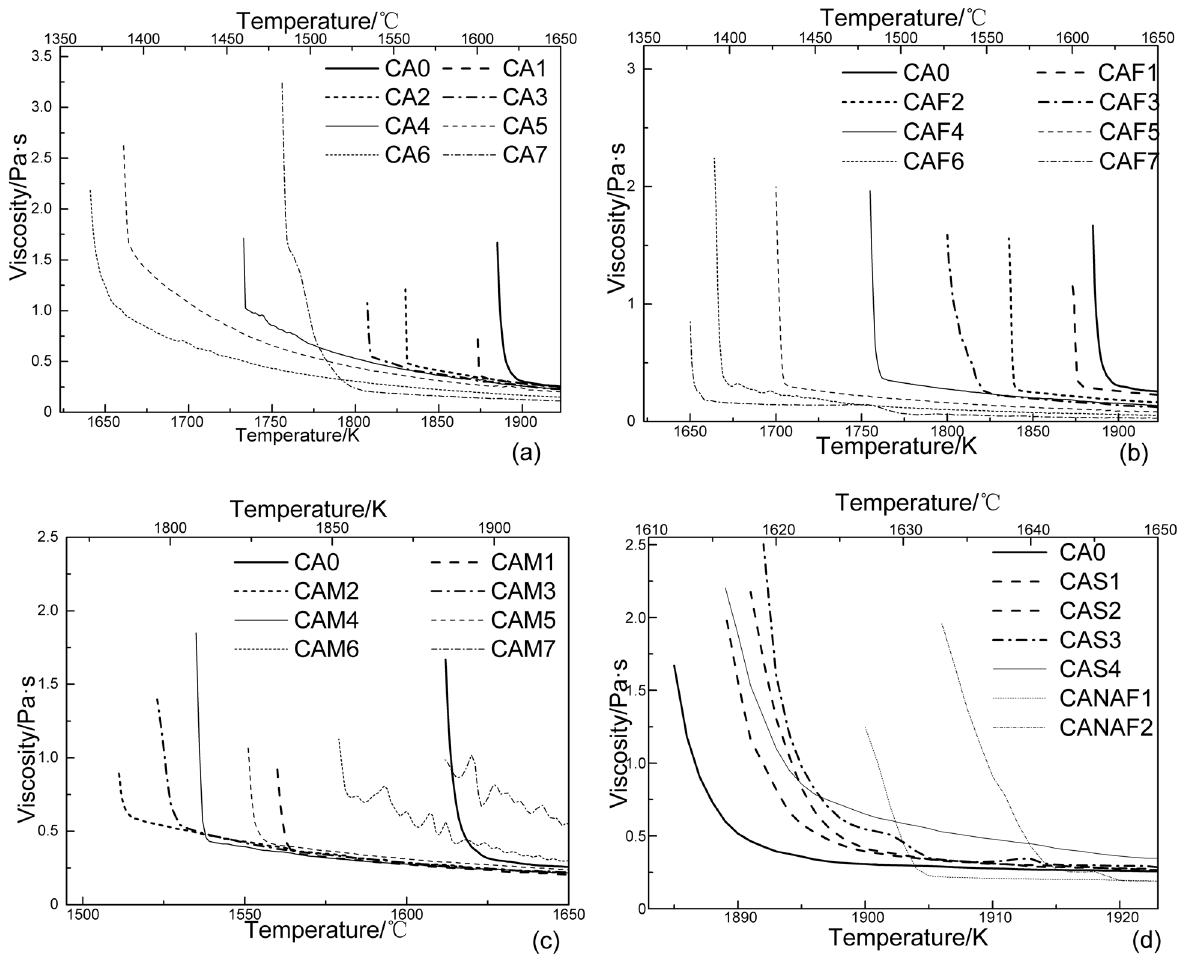
Figure 2: E ff ect of di ff erent additives on viscosity – temperature curves of slags: ( a ) CaO; ( b ) CaF 2 ; ( c ) MgO; SiO 2 ; and ( d ) Na 3 AlF 6 .